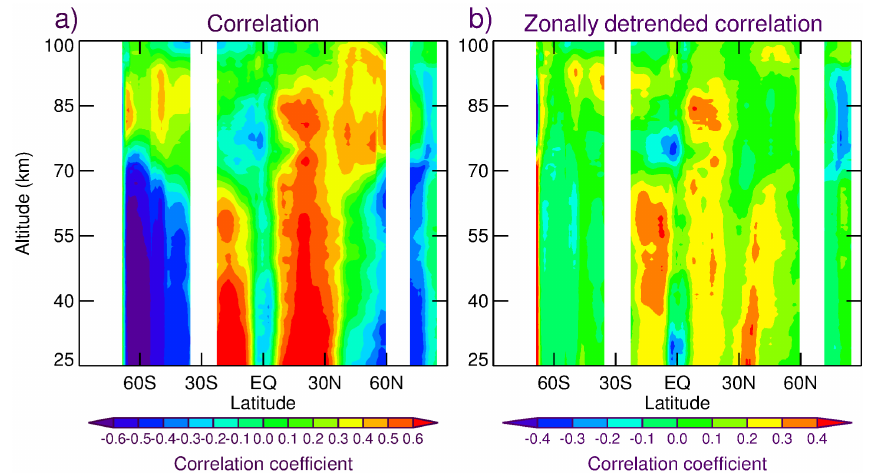
Figure 5. Altitude–latitude cross section of (a) correlation and (b) zonally detrended correlation between SABER GWMF and SST for 150 ◦